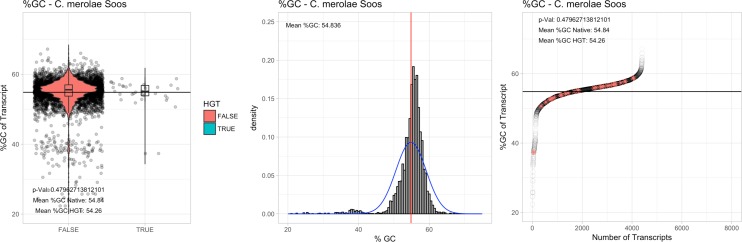
%GC – Cyanidioschyzon merolae 10D: (Left) Violin plot showing the %GC distribution across native transcripts and HGT candidates.(Mid) Cumulative %GC distribution of transcripts. Red line shows the average, blue line a normal distribution based on the average value. (Right) Ranking all transcripts based upon their %GC content. Red ‘*' demarks HGT candidates. As the %GC content was normally distributed, students test was applied for the determination of significant differences between the native gene and the HGT candidate subset.